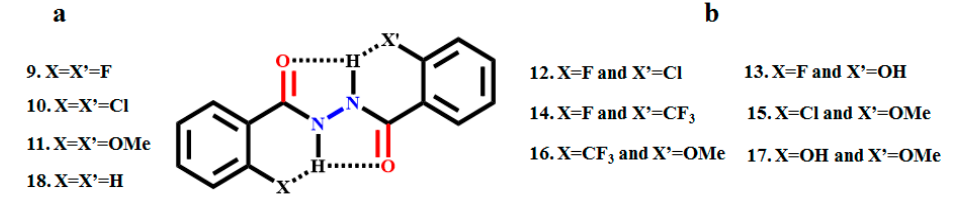
Figure 14. The chemical structures of 2-X- N -(2-X’) benzohydrazide derivatives; ( a ) symmetrically substituted molecules and ( b ) asymmetrically substituted molecules.